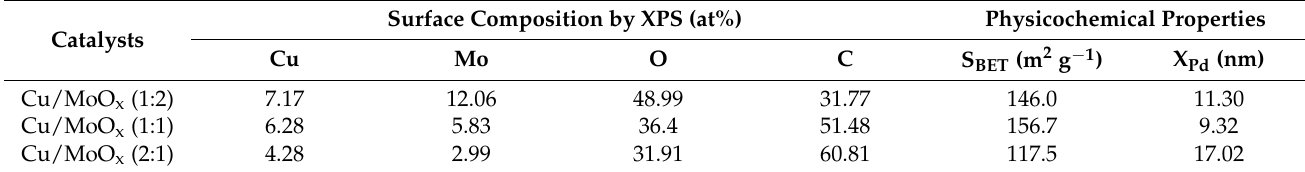
Figure 5. ( a ) Survey X-ray photoelectron spectra for Cu/MoO x as well as the core level of ( b ) O1s spectra. Table 1. Atomic composition by XPS, surface area, and pore size distribution.